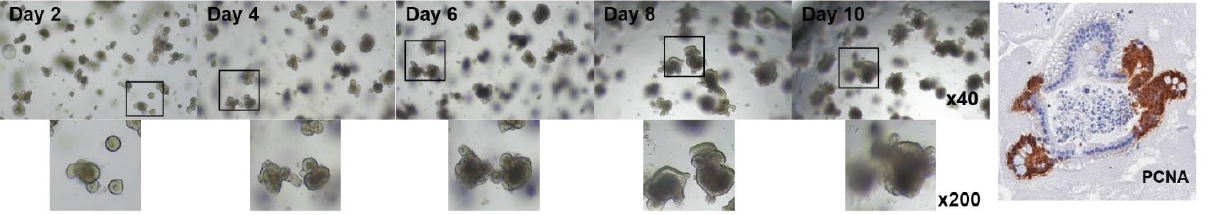
Figure 3. Microscopic appearance of jejunal, ileal, and colonic organoids cultured in differentiation medium. The control organoids cultured in the maintenance medium formed spheroids, while those cultured in the differentiation medium formed enteroids. Jejunal organoids had budding structures, while the ileal and colonial organoids formed thick-walled structures.